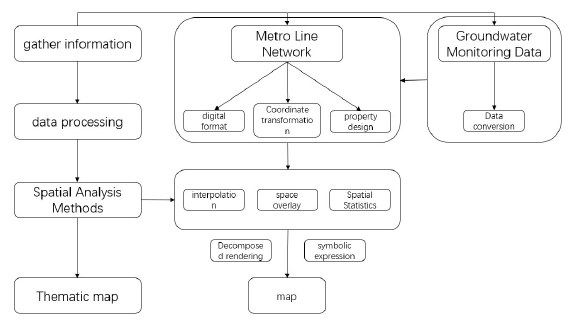
Figure 2. Technical flow